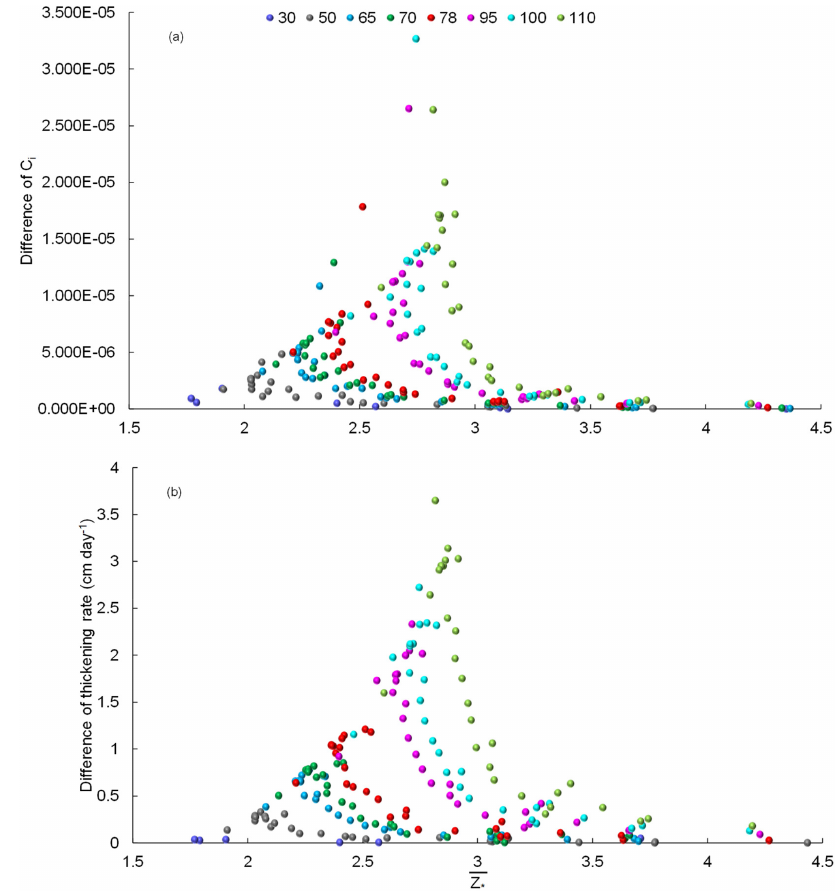
Figure 10. Relationship between Z ∗ and differences in (a) C i and (b) thickening rate calculated by VM and VU models (VM minus VU), classified by outflow supercooled layer thickness D ini